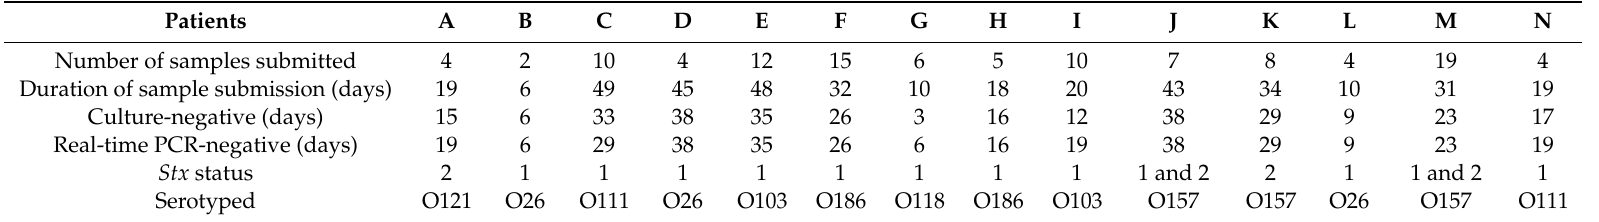
Table 2. STEC patient sample